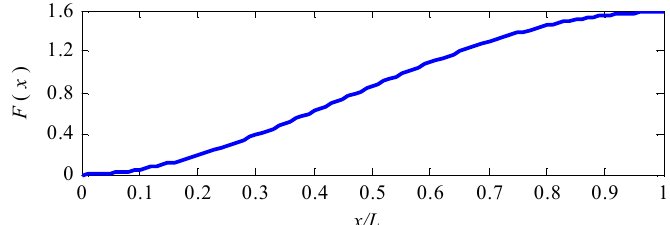
Figure 3. The first mode shape of clamped sliding beam function.